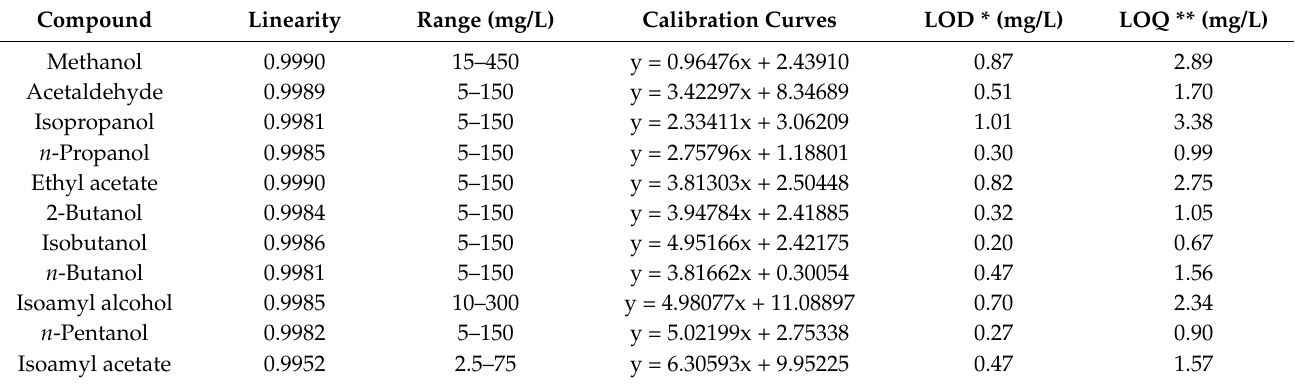
Table 2. Validation parameters for the analyzed compounds under investigation